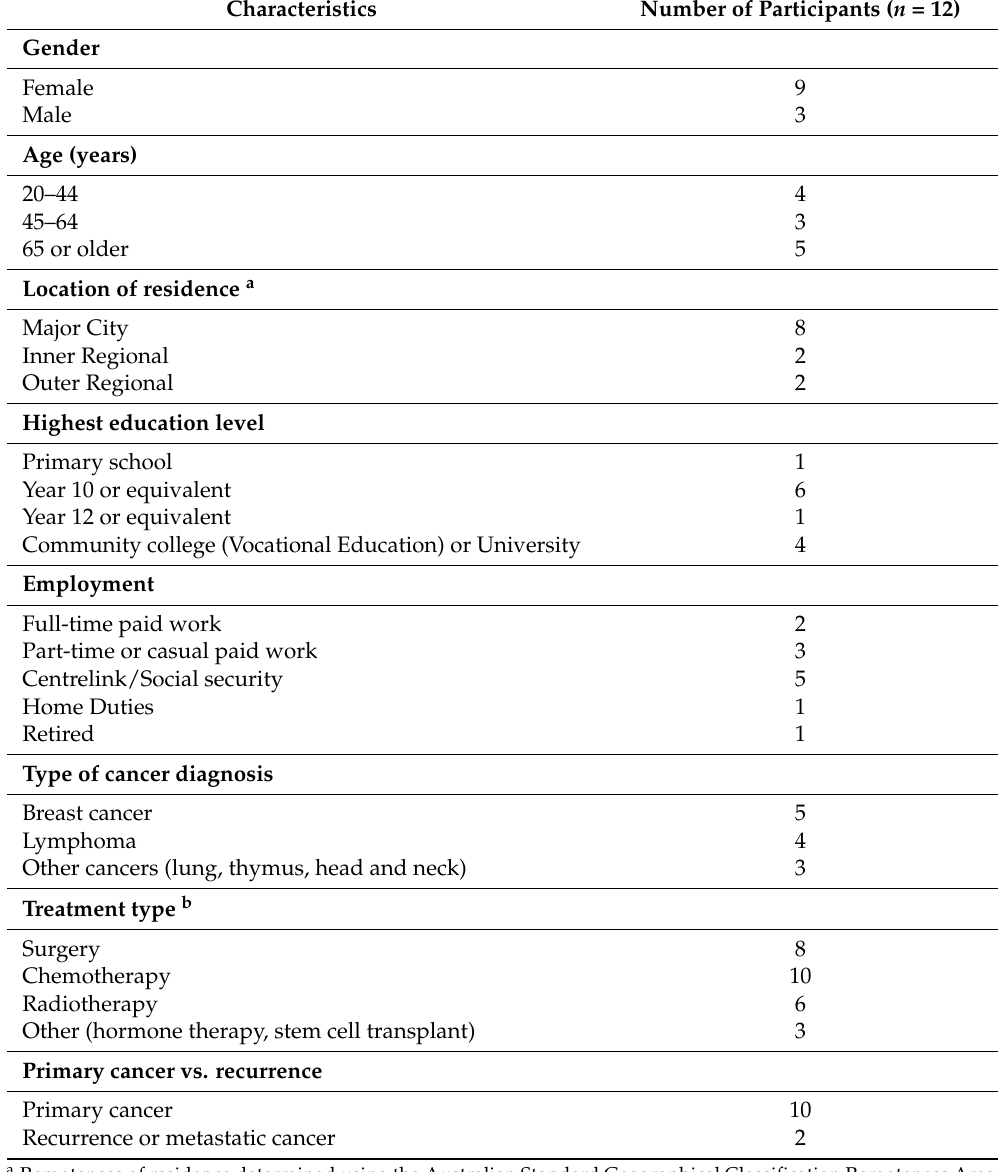
Table 2. Characteristics of study